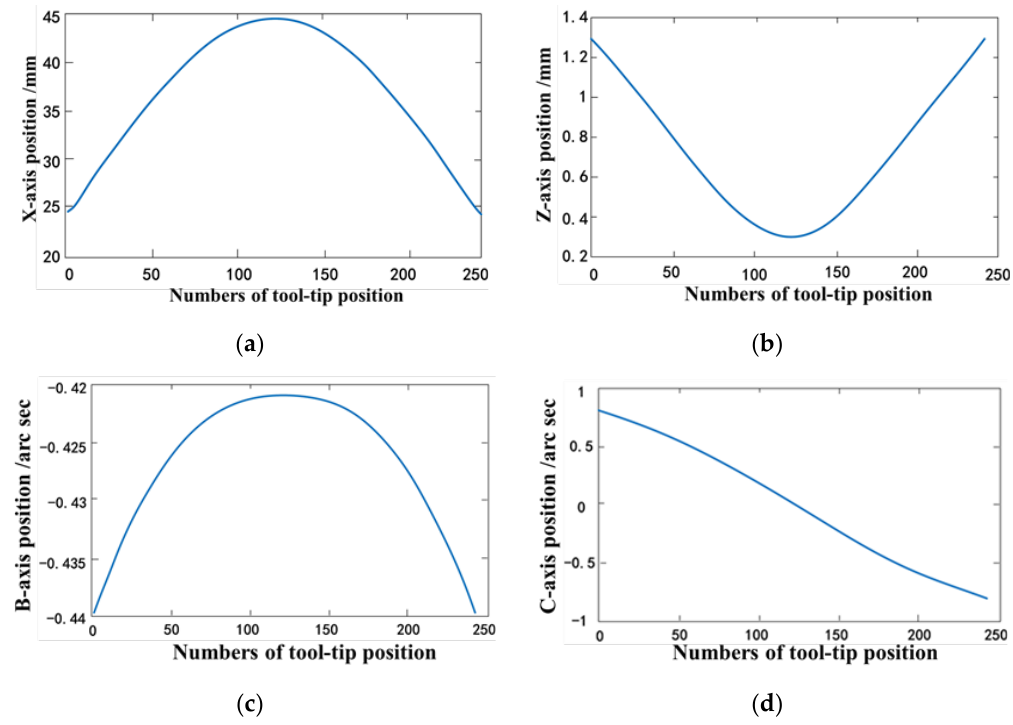
Figure 7. Axis position obtained from theoretical kinematic structure: ( a ) X − axis position, ( b ) Z − axis position, ( c ) B − axis position, and ( d ) C − axis position.